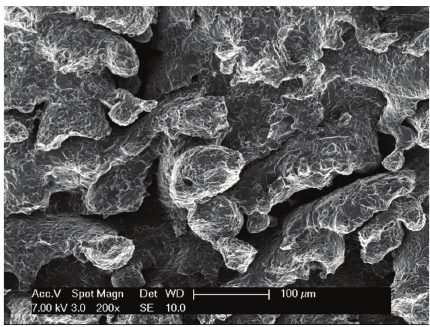
Figure 1: Scanning electron microscopy (SEM) of the 3DP/AM porous implant